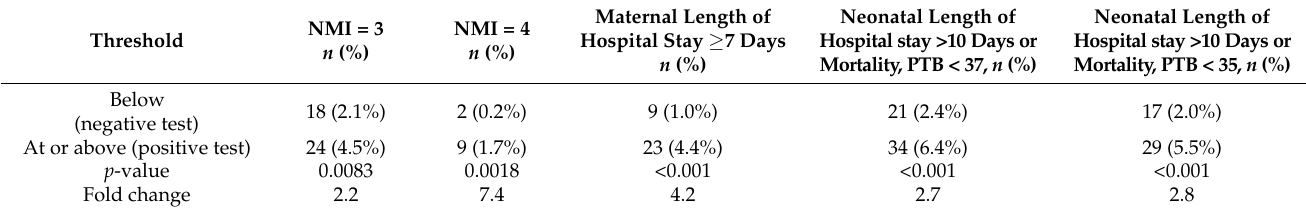
Figure 1. Kaplan–Meier curve of neonatal length of stay in days for all neonates. The fraction of neonates remaining in the hospital is plotted as a function of the length of hospital stay in days. Neonates without recorded hospital stays were omitted (A:9, B:3). Verification phase subjects from the PAPR study ( A ) and validation phase subjects from the TREETOP study ( B ) were stratified into higher- (gold) and lower-risk (blue) groups defined by the proteomic biomarker threshold − 1.37. Those preterm neonates with stays >10 days or perinatal mortality were increased by close to 3-fold at or above the threshold (Table 2, p -value < 0.001). Table 2. Comparisons of maternal and neonatal outcomes in the combined PAPR and TREETOP populations at or above versus below the threshold of −